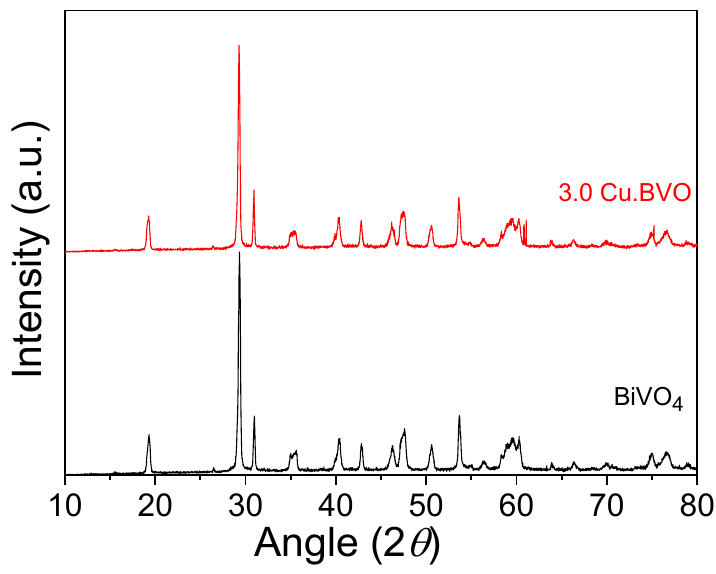
Figure 1. XRD patterns of pure BiVO 4 and 3.0 Cu.BVO.